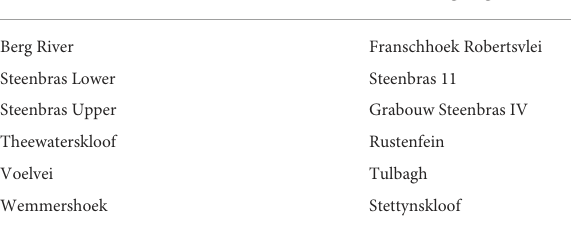
TABLE 2 The Big Six dams and their corresponding rainfall gauge